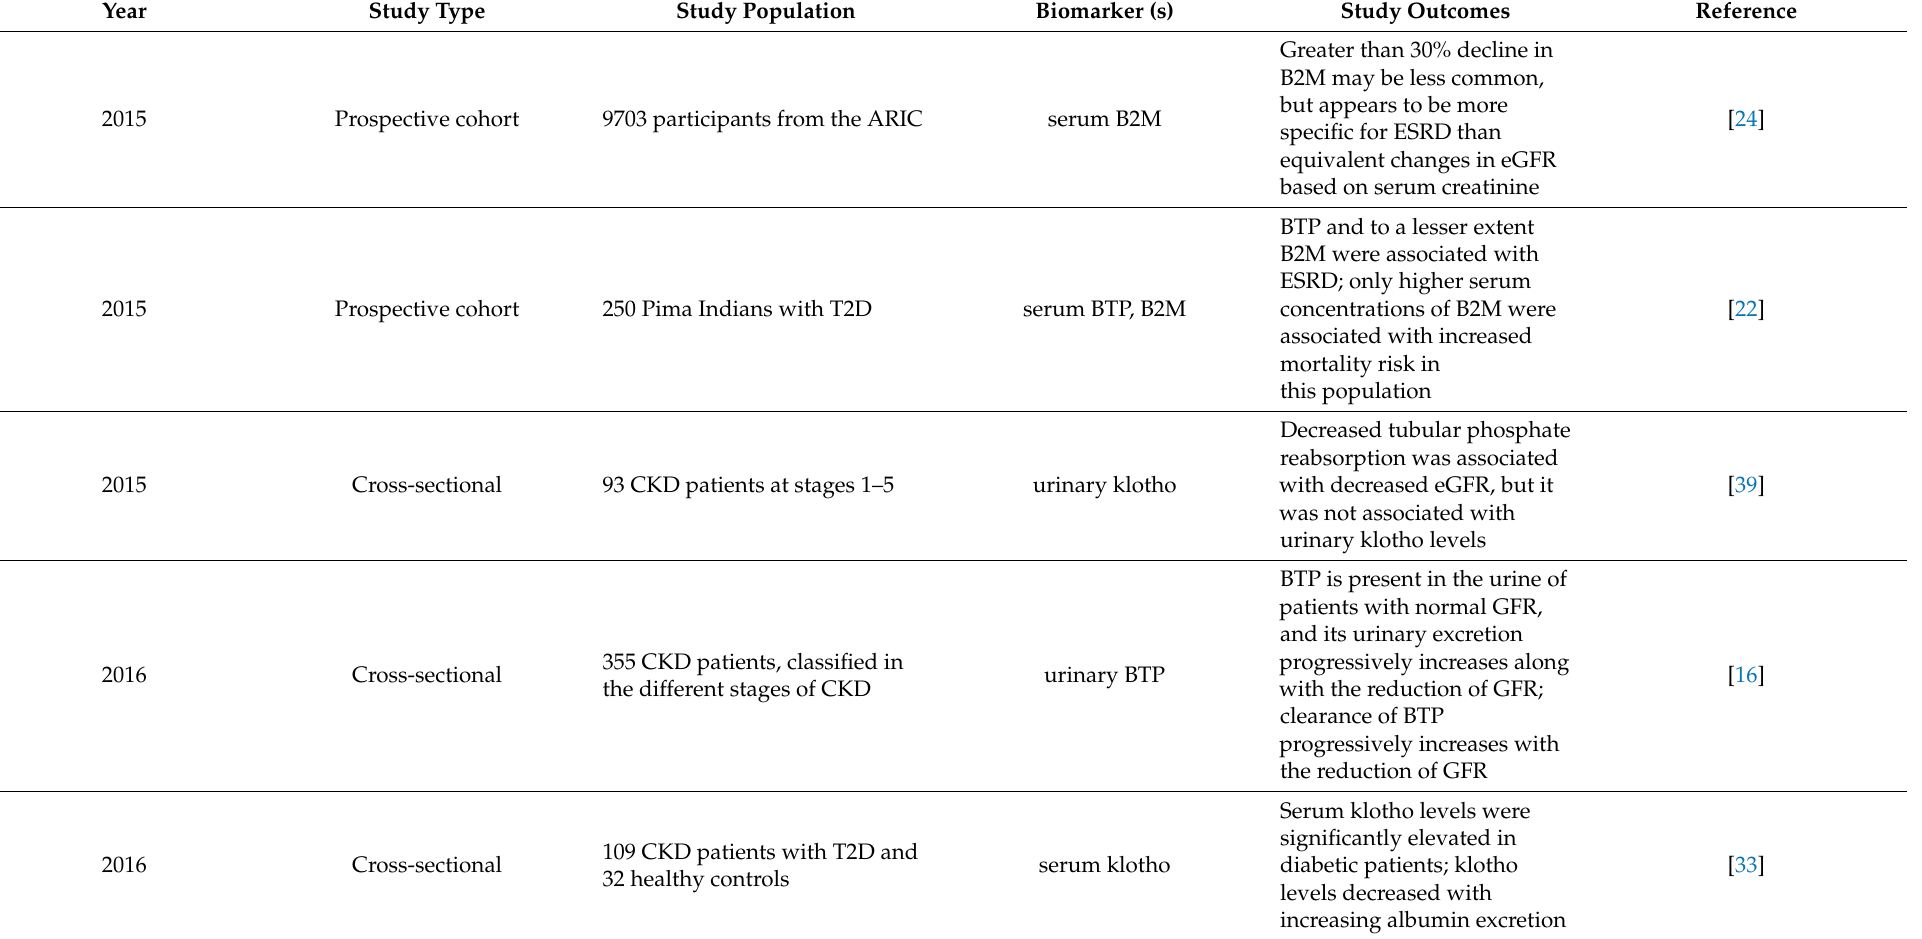
Table 1. Research studies on biomarkers of renal function and main outcomes in CKD